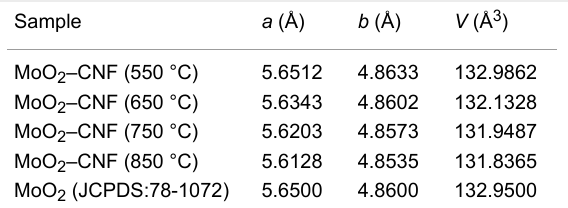
Table 2: Effect of calcination temperature on BET surface area and particle size of MoO 2 . Sample